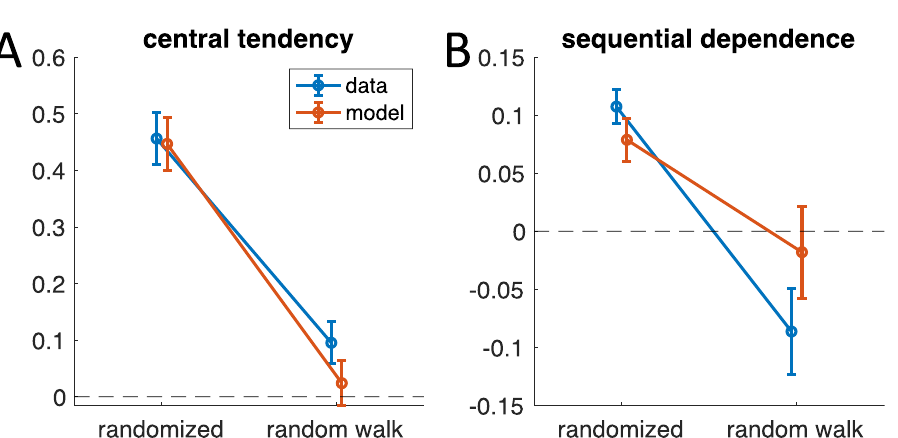
Figure 8. Summary of average results for both conditions of the duration reproduction experiment. Blue: data; orange: model. Error bars indicate standard error of the mean. ( A) Central tendency is significantly smaller during random walk (t-test, n = 14, p < 0.0001, Cohen’s d = 2.17). ( B ) Sequential dependence becomes on average negative with a significant difference between conditions (t-test, n = 14, p = 0.00016, Cohen’s d = 1.74). In A and B, the model values for the randomized condition are averages from the fitted simulation, while model values for the random walk condition are averaged predictions using the model parameters from the randomized